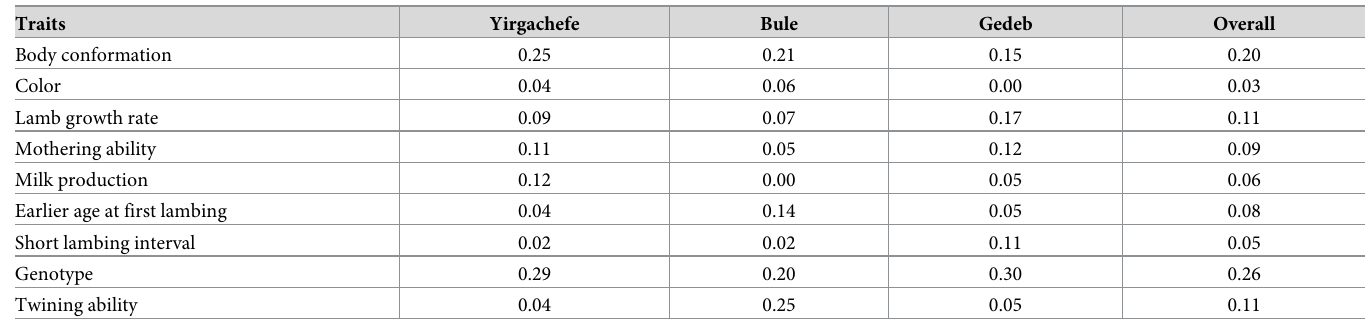
Table 8. Indices of various criteria used to select best ewes in sheep reproduction.